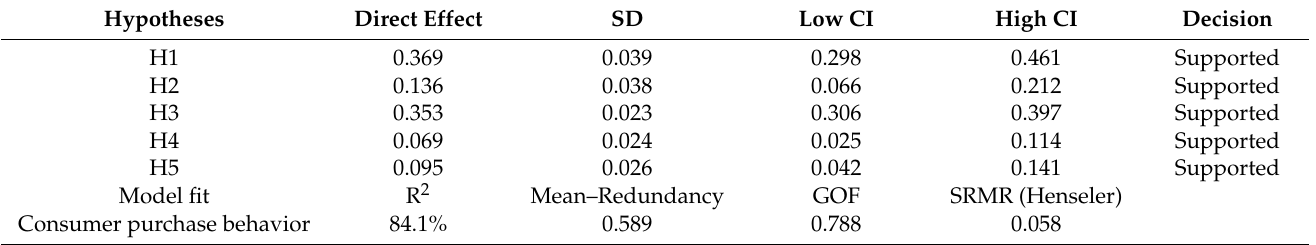
Table 4. Results of research hypotheses and model